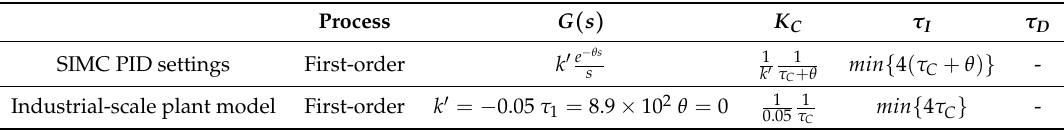
Table 2. PI parameter calculation using the SIMC